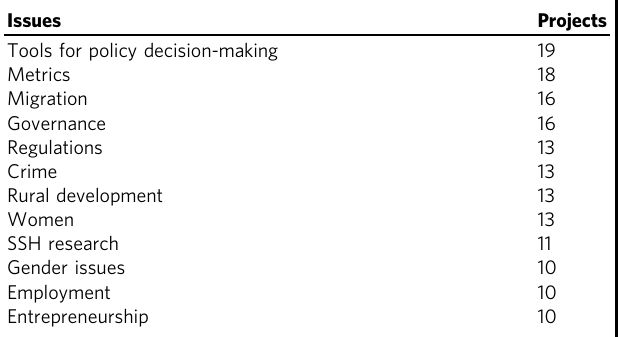
Table 3 Top issues in the social sciences and humanities funded under FP6.